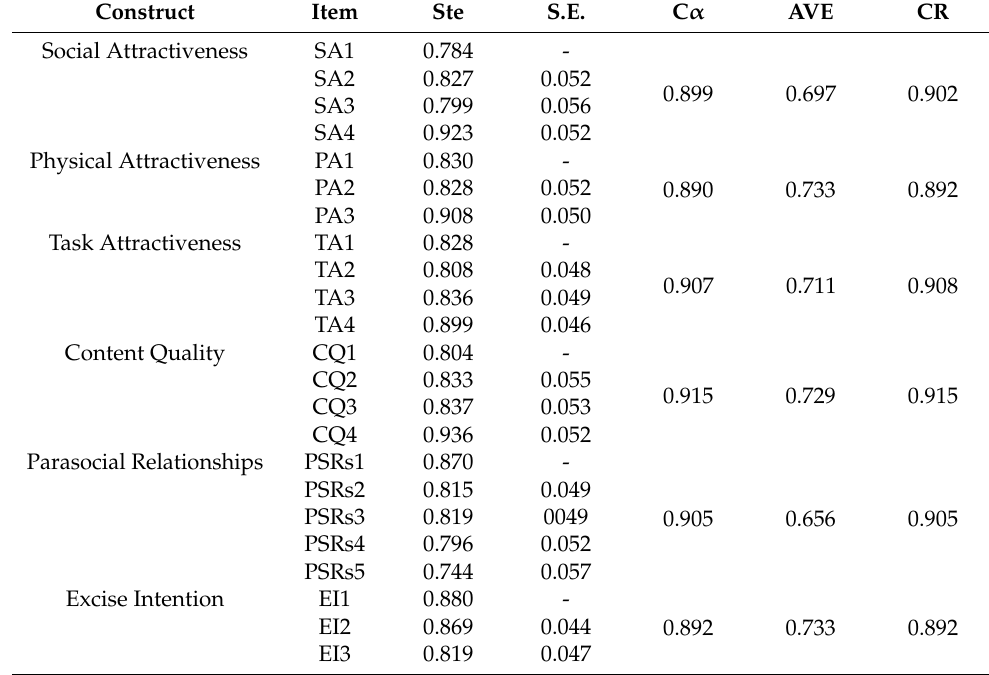
Table 2. Reliability and convergent validity test.